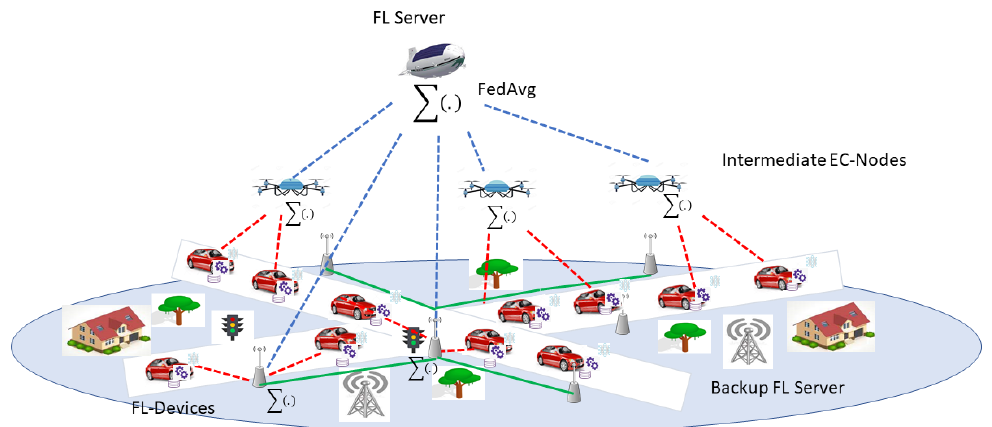
Figure 7. The hierarchical FL platform in a Multi-EC VN architecture. Reprinted/adapted with permission from Ref. [78]. 2021, Attribution 4.0 International (CC BY 4.0) .